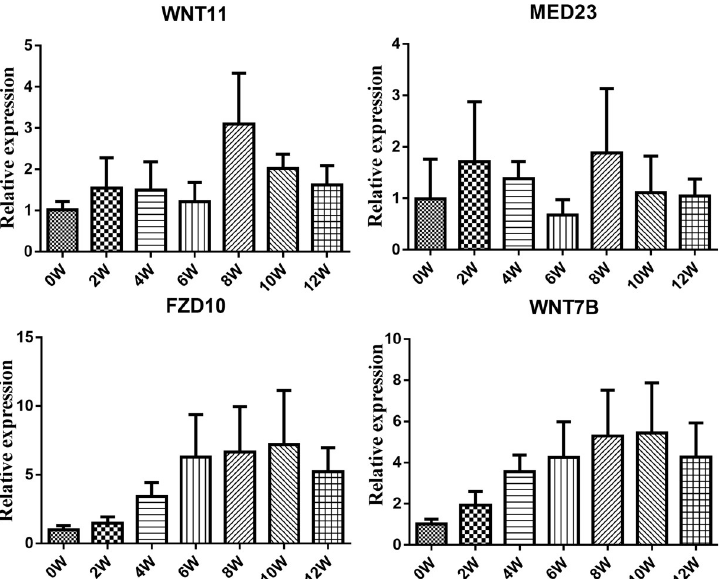
Fig 3. qRT-PCR validation of DEGs involved in the feather cycle. Changes in DEGs in feather follicles from the dorsal neck of the chicken at 0, 2, 4, 6, 8, 10 and 12 weeks.